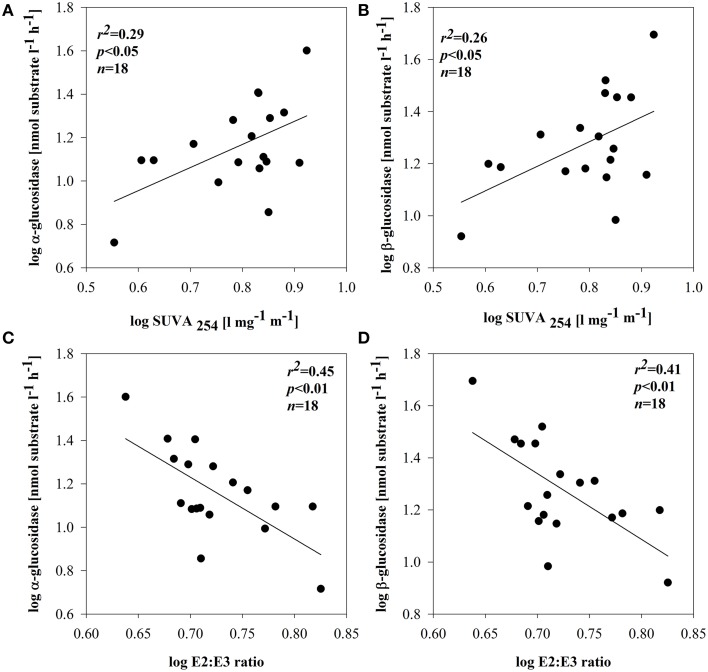
Relationships between SUVA254 and: α-glucosidase (A) or β-glucosidase (B) and E2:E3 ratio and: α-glucosidase (C) or β-glucosidase (D) in subsystem II. All data were log-transformed.